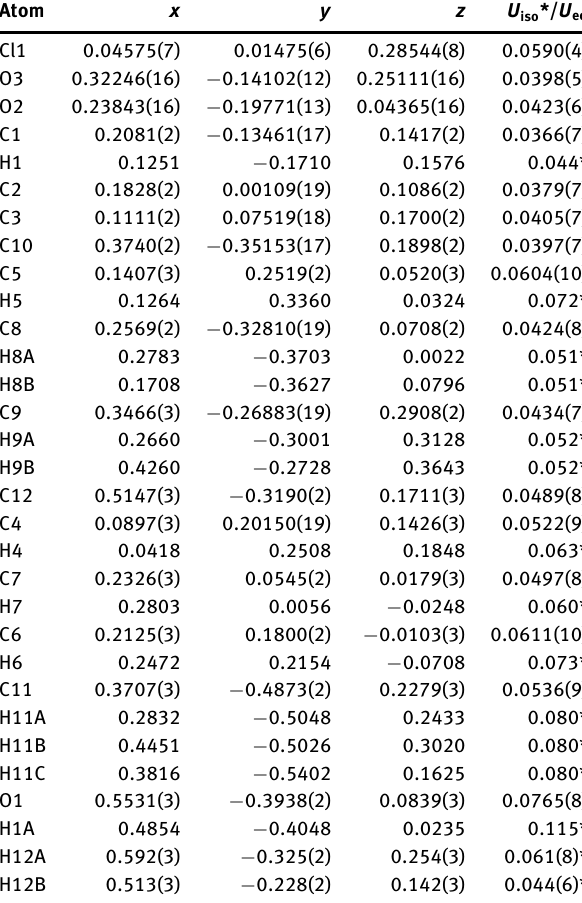
Table 2: Fractional atomic coordinates and isotropic or equivalent isotropic displacement parameters (Å 2